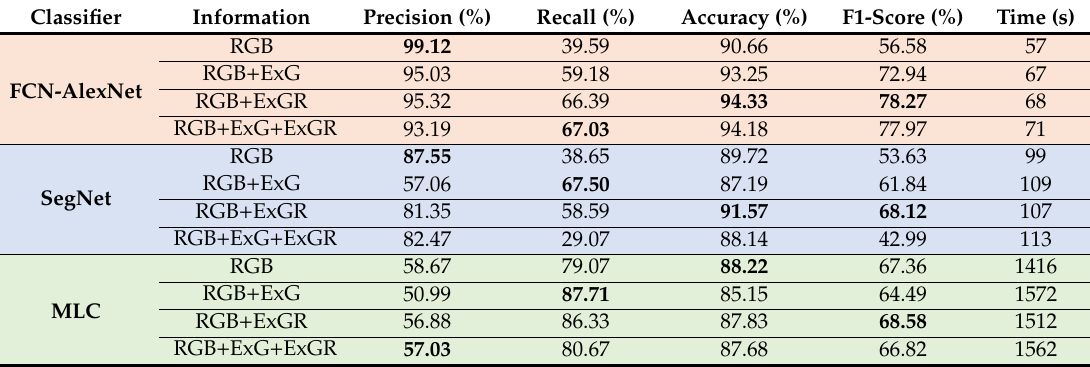
Figure 10. F1-score and accuracy comparison on the 2017 testing dataset for rice lodging. Table 8. Results on the 2019 testing dataset for rice lodging category (the highest value is shown in bold and the colors shadow corresponds to three classifiers in Figures 10 and